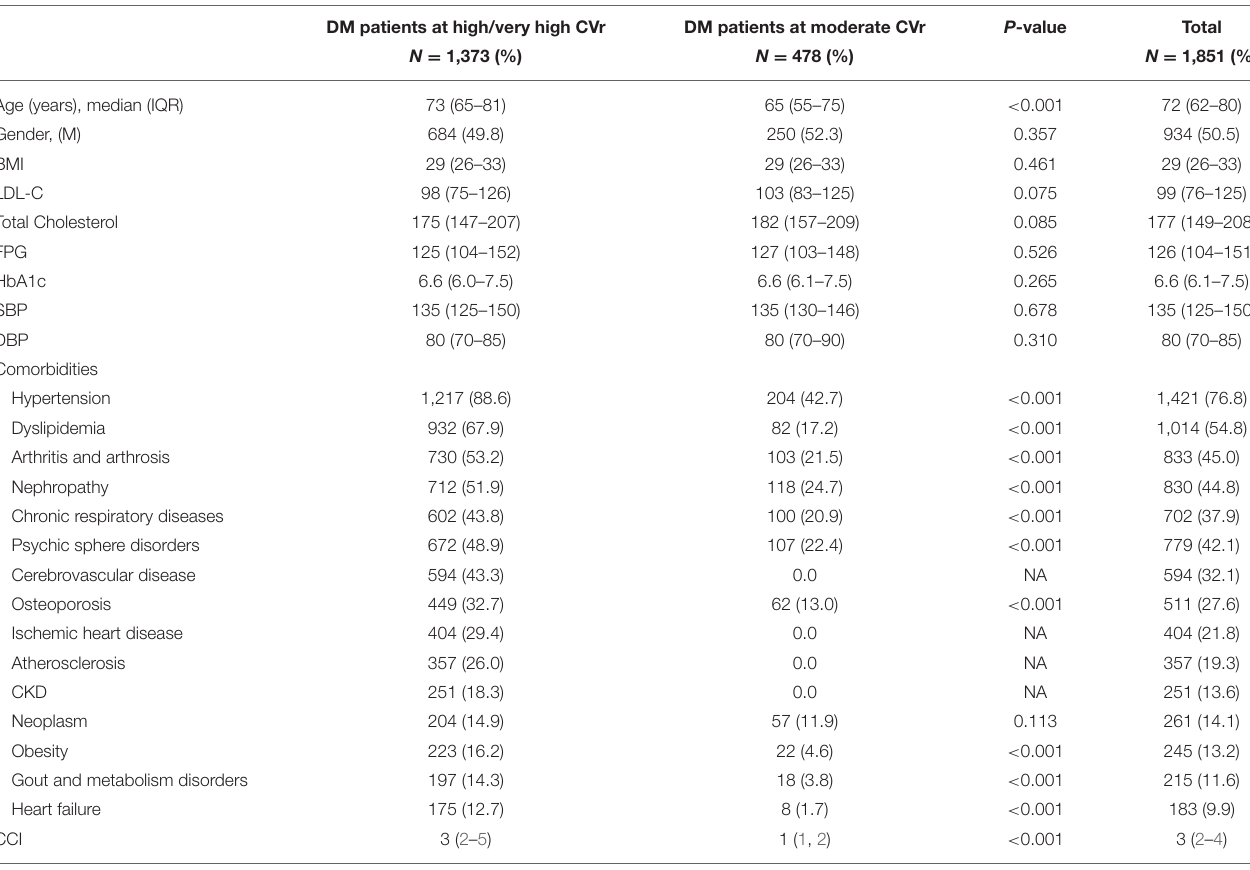
TABLE 1 | Characteristics of the patient with diabetes stratified by cardiovascular risk. DM patients at high/very high CVr DM patients at moderate CVr P